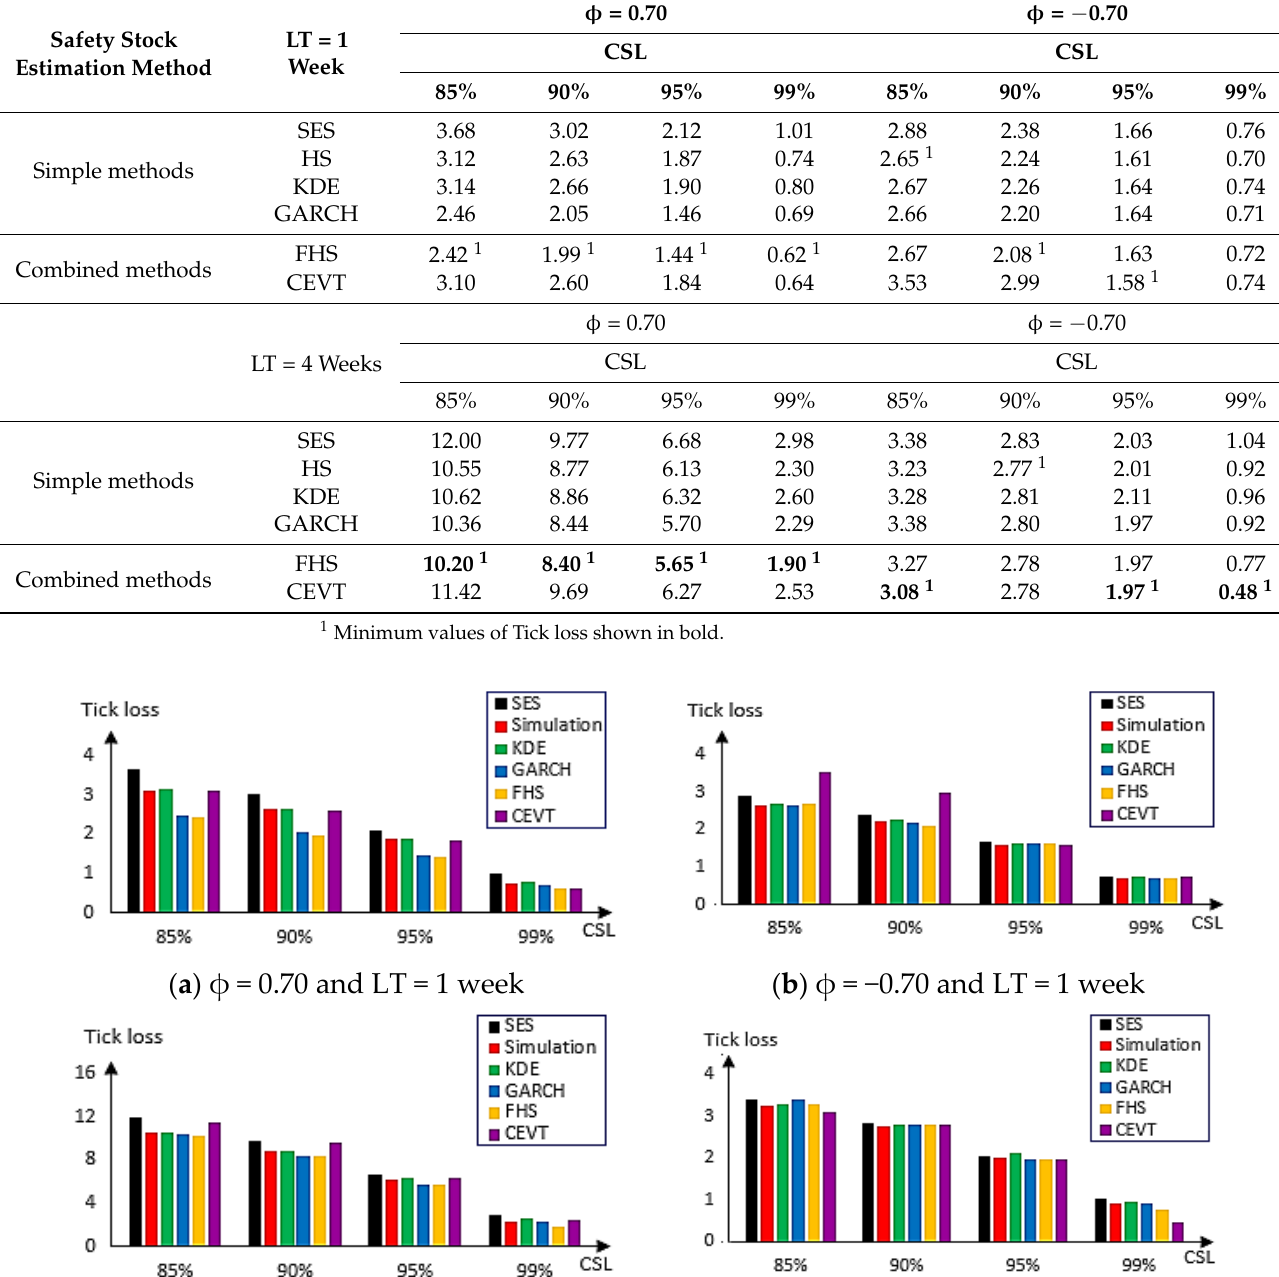
Table 2. Tick loss function values corresponding to ϕ = 0.70 and ϕ = −0.70 when forecasting errors